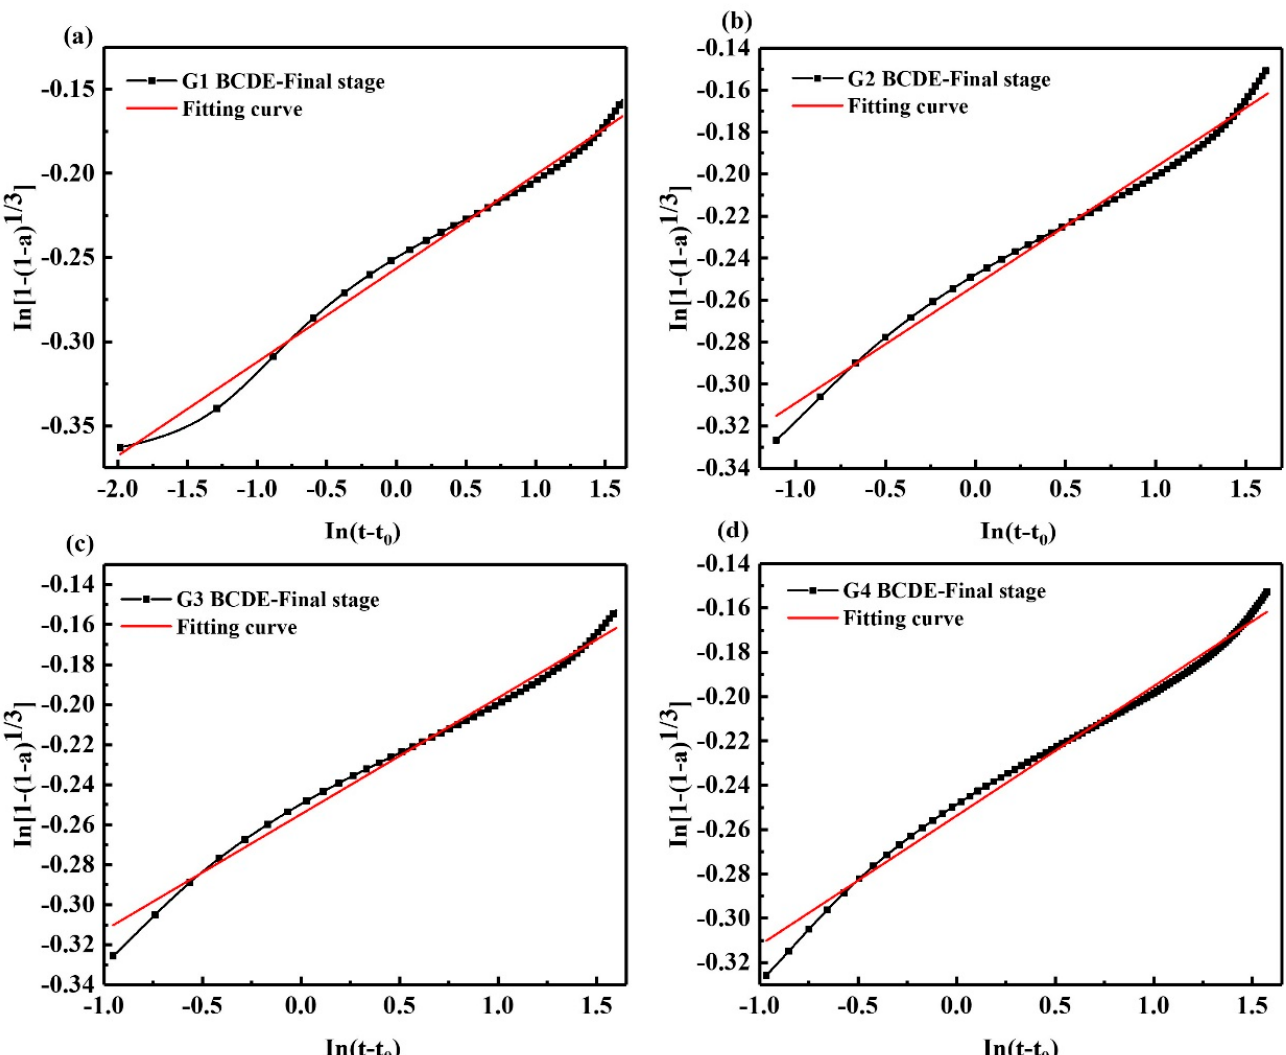
Figure 7. Kondo equation piecewise fitting hydration acceleration final stage (BCDE-final stage);